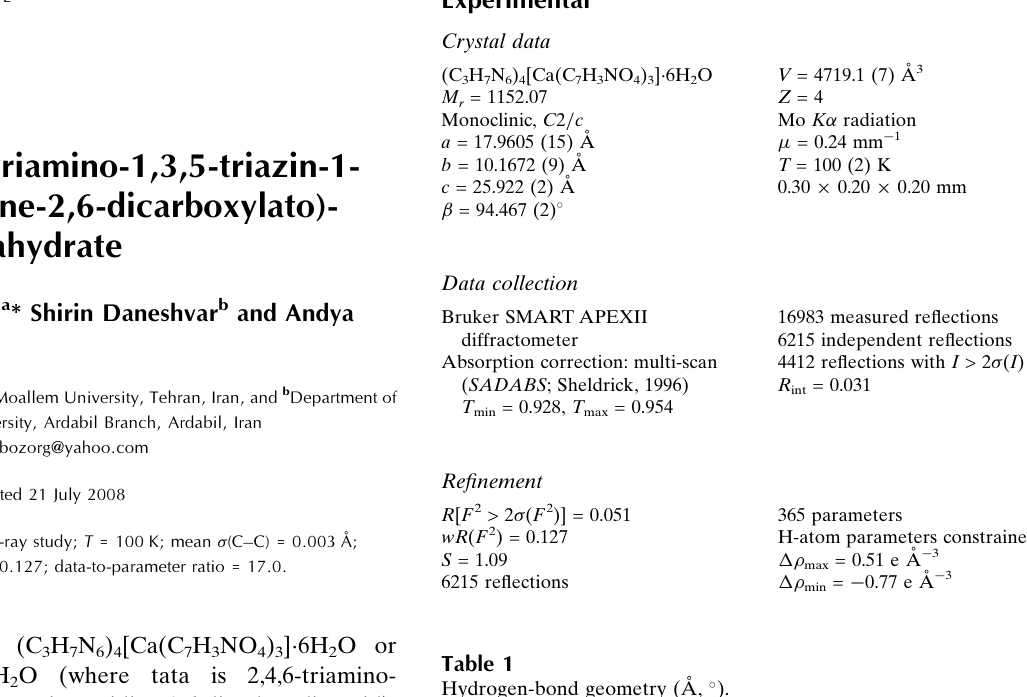
Hydrogen-bond geometry (A˚ , (cid:3) ). D —H (cid:1)(cid:1)(cid:1)